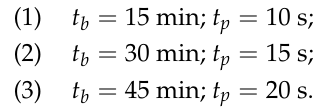
Figure 15. Collapse during printing for specimens of mix B640/SF/FA/LP. ( a ) 𝑡 (cid:3029) = 15 min ; 𝑡 (cid:3043) = 10 s ;